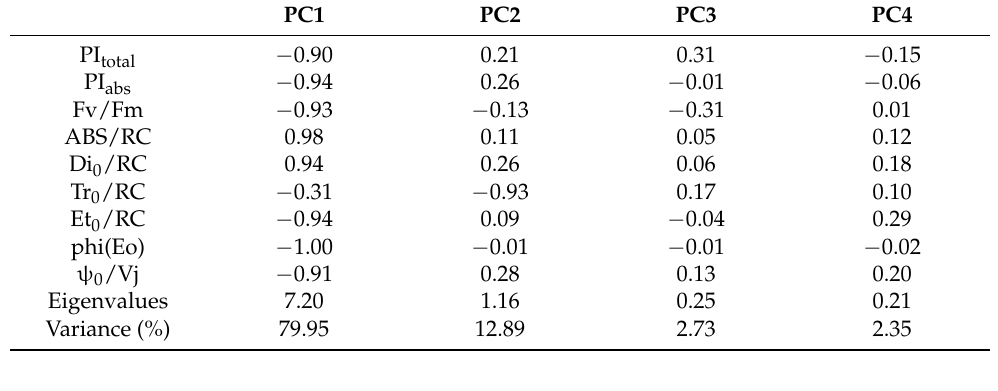
Table 2. Correlations between variables and dimensions, eigenvalues, and percentage of variance for the first four dimensions resulting from the PCA analysis on photosynthetic variables.